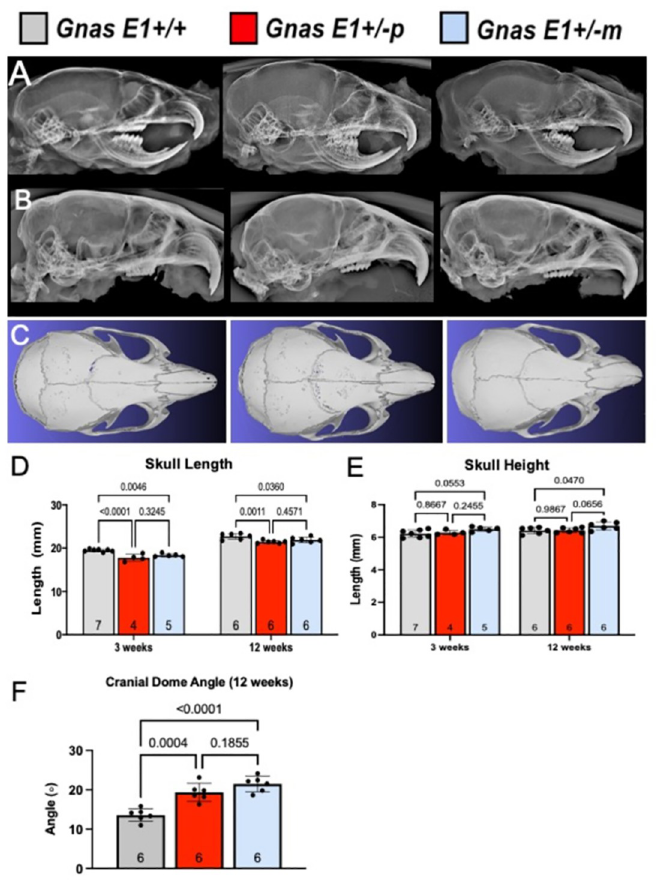
Fig 3. AHO mouse model generated by heterozygous inactivation of Gnas exon 1 ( Gnas E1+/- ) displays cranial hypoplasia. (A, B) Representative x-ray images of the skull of (A) 3 week and (B) 12-week-old WT , Gnas E1+/-p and Gnas E1+/-m mice. (C) Representative three dimensional reconstructions of the skull of 12-week-old WT , Gnas E1+/-p and Gnas E1+/-m mice. (D) Measurements of total skull length demonstrate that both Gnas E1+/-p and Gnas E1+/-m mice display a reduction in skull length at both 3 and 12 weeks of age when compared to WT . (E) Measurement of total skull height demonstrate no significant variations between WT and Gnas E1+/- mice at 3 weeks of age. Gnas E1 +/-m mice at 12 weeks exhibited a mild but statistically significant increase in skull height when compared to WT mice. (F) Measurement of cranial dome angle demonstrates that both 12-week-old Gnas E1+/-m and Gnas E1+/-p mice exhibit significantly increased cranial dome angles when compared to WT mice. Sample size per genotype per experiment is listed on each graph. All statistical tests were performed by ANOVA with post-hoc Tukey tests for multiple comparisons, and p -values are displayed for each